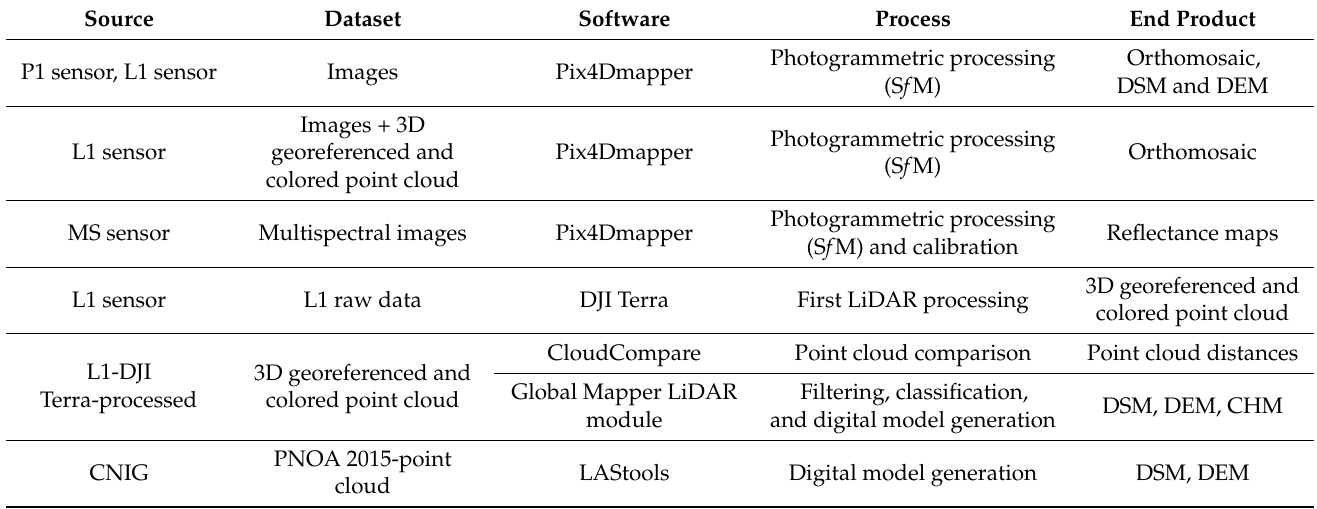
Table 3. Summary of processing operations and performing software as a function of the UAV dataset